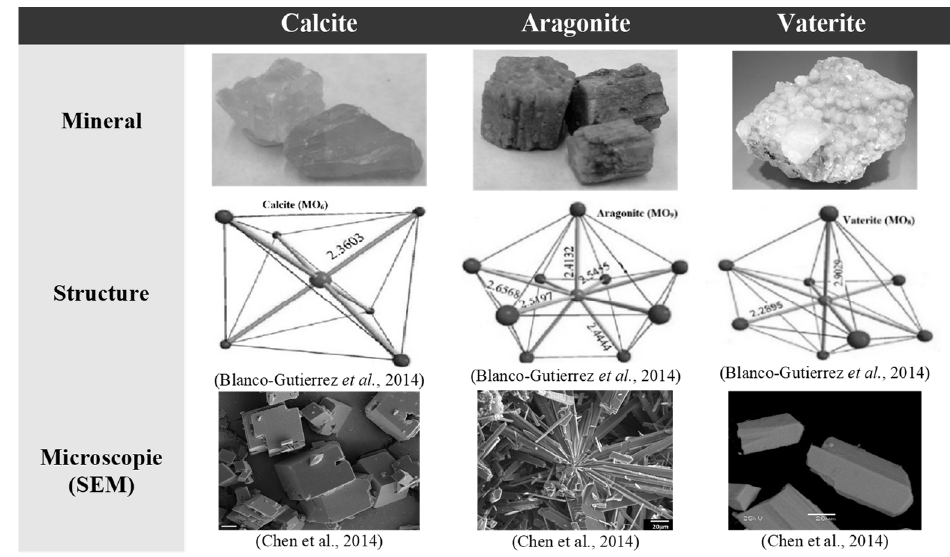
Figure 4. Main mineral shapes of calcium carbonate [9–11].